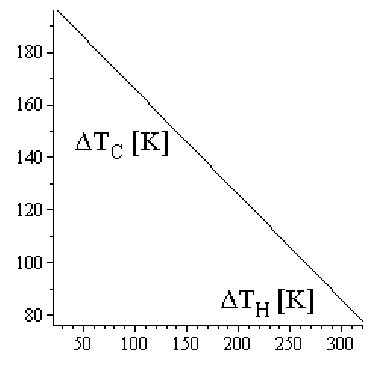
Figure 9. Δ T C dependence of Δ T H —case “d”.